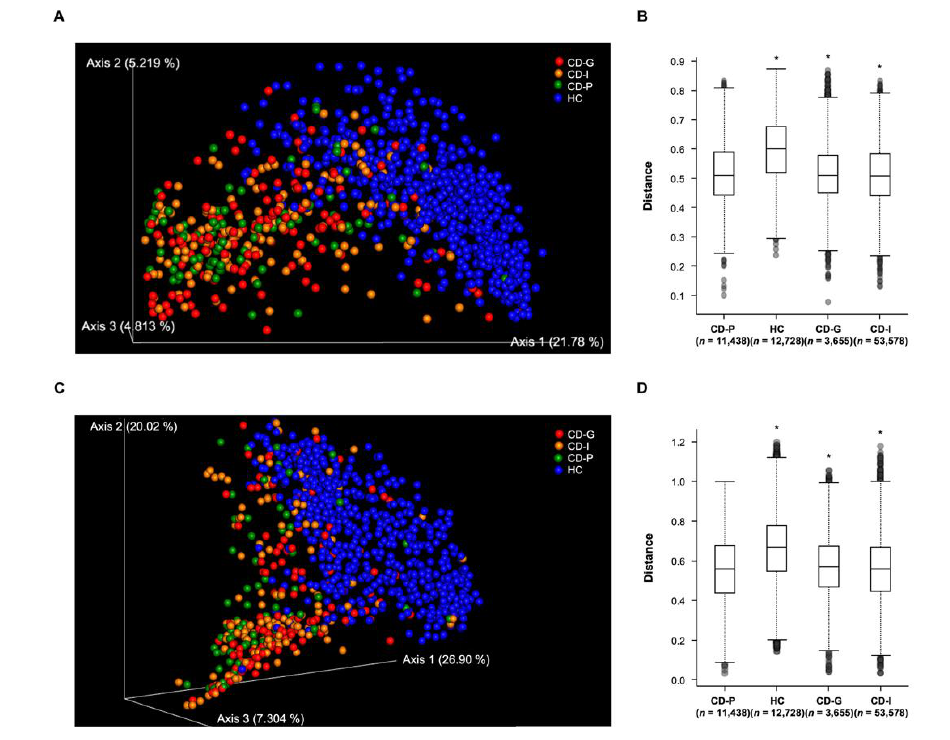
Figure 3. Beta diversity comparisons of gut microbial communities among groups, according to the Crohn’s disease prognosis. ( A ) Unweighted UniFrac distance by 3D principal coordinates analysis (PCoA) plot, ( B ) Unweighted UniFrac distance by boxplot, ( C ) Weighted UniFrac distance by PCoA plot, ( D ) Weighted UniFrac distance by boxplot. The y-axes represent the distance of each group to the CD-P group (baseline). * q < 0.05 (pairwise PERMANOVA); CD-G = good prognosis group; CD-I = intermediate prognosis group; CD-P = poor prognosis group; HC = health control.